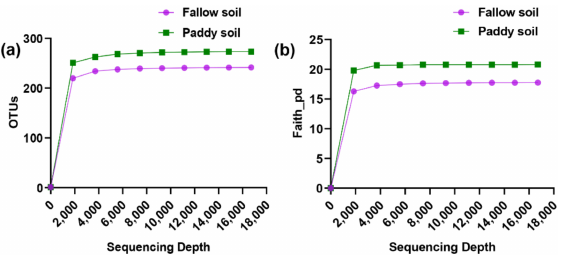
Figure 1. Rarefaction curves of soil samples associated with the fallow and paddy soil. ( a ) Rarefaction curve showed the observed OTUs against sequencing depth in each soil type; ( b ) Rarefaction curves based on phylogenetic diversity (Faith_pd). Solid circles and squares indicated the means of OTU and Faith_pd of fallow and paddy soil samples against sequencing depth.